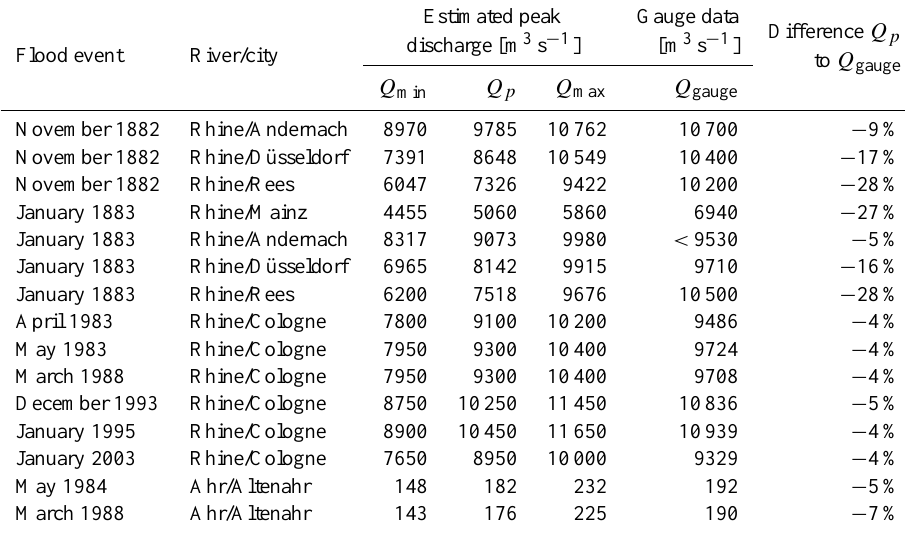
Table 1. Comparison chart for estimated and measured peak discharges of selected flood events (partly from Meurs, 2006, and Roggenkamp,